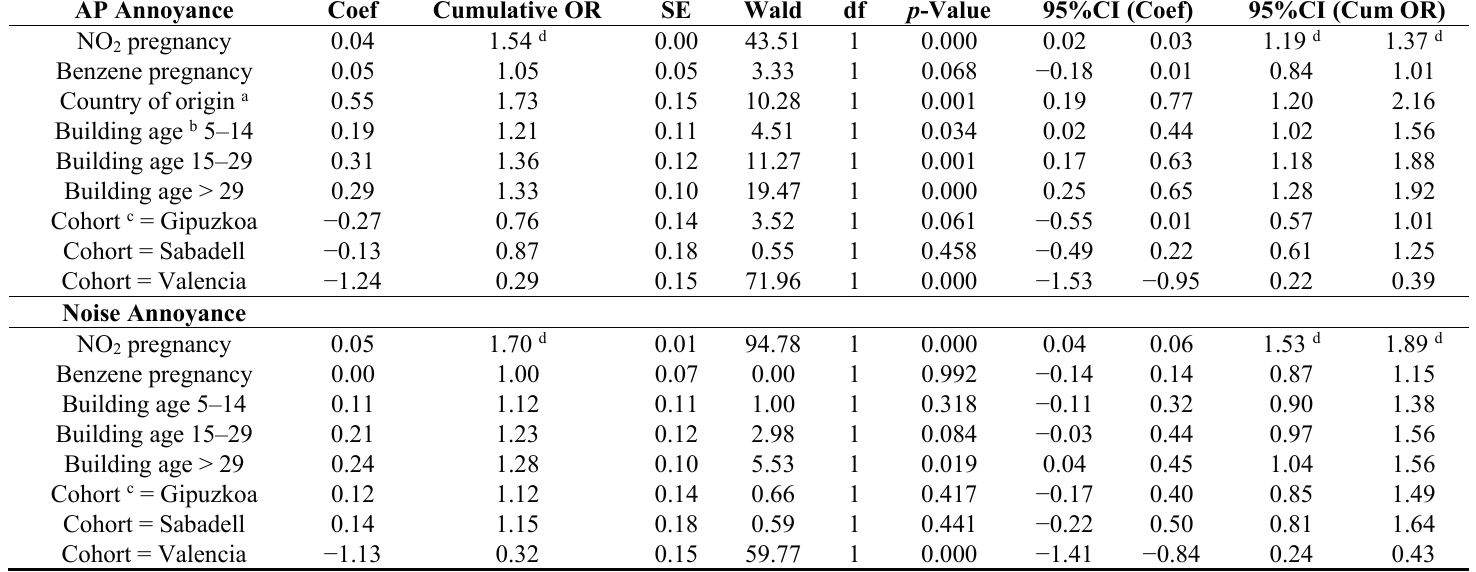
Table 5. Multivariable ordinal logistic model for perceived annoyance and associated